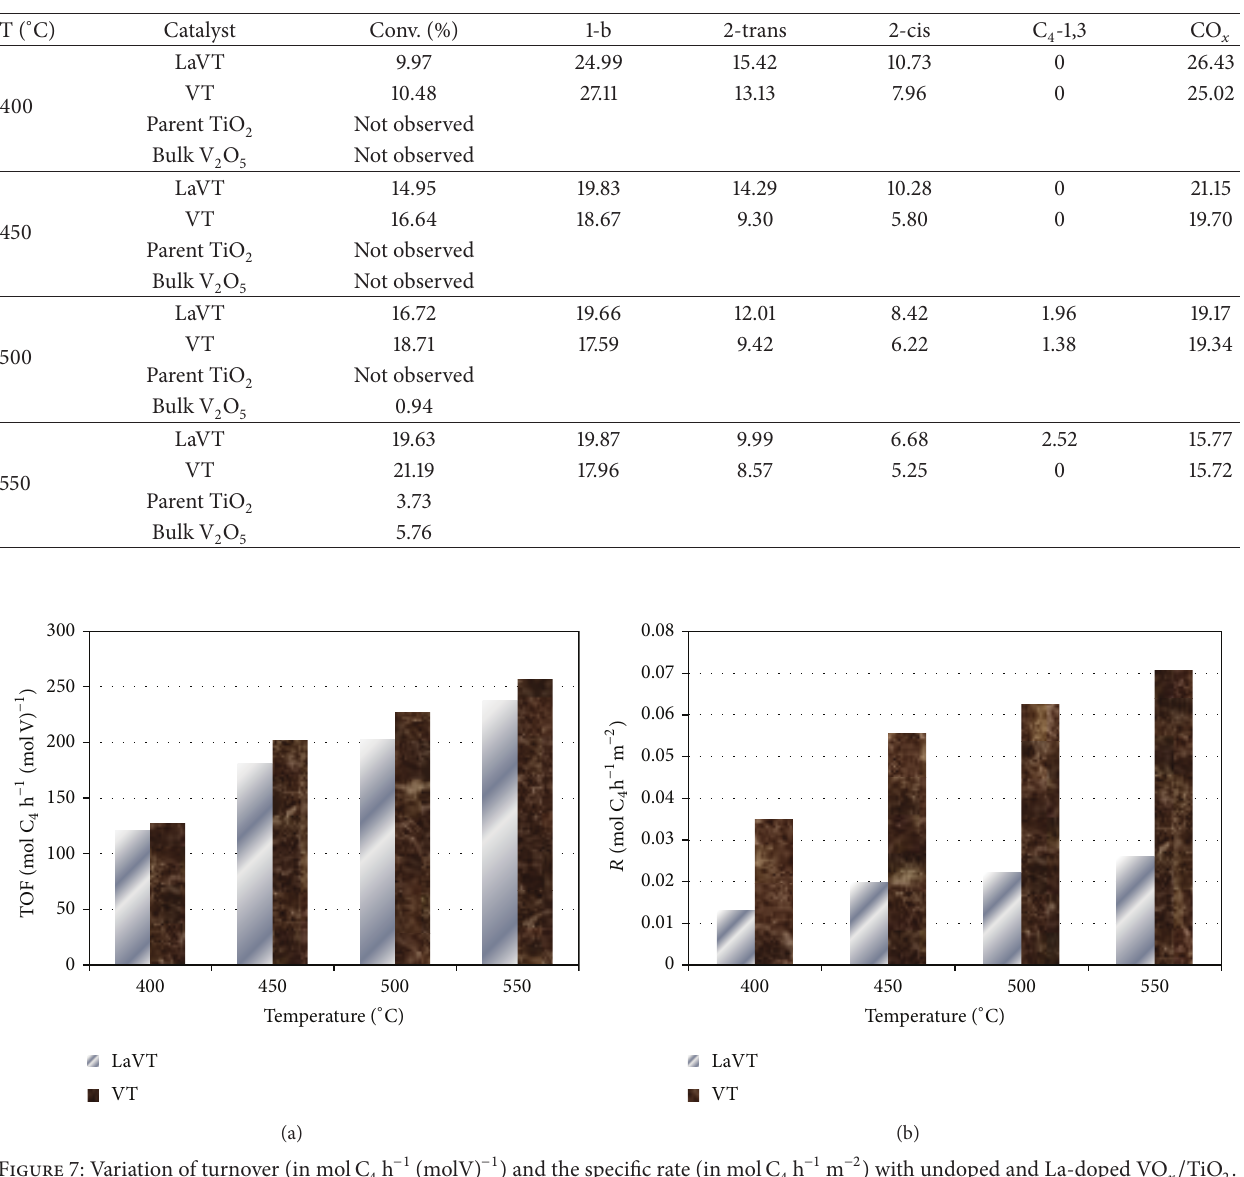
Table 2: Results of catalytic tests in ODH of n-butane (C